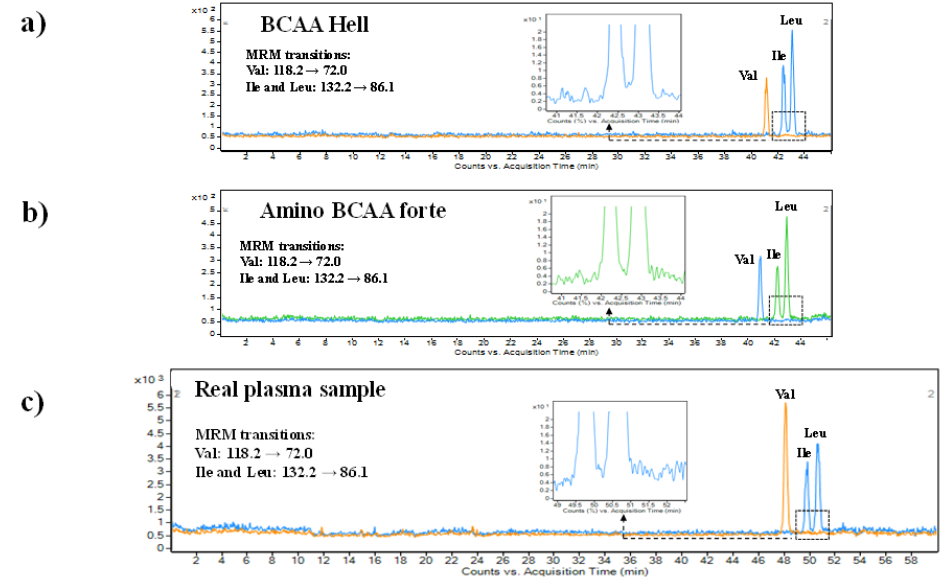
Figure 5. Extracted MRM records of Val, Ile, and Leu were obtained from the analysis of BCAA in an energy drink ( a ), sport supplement ( b ), and real human plasma sample ( c ). For details of the capillary electrophoresis-tandem mass spectrometry method, see Section